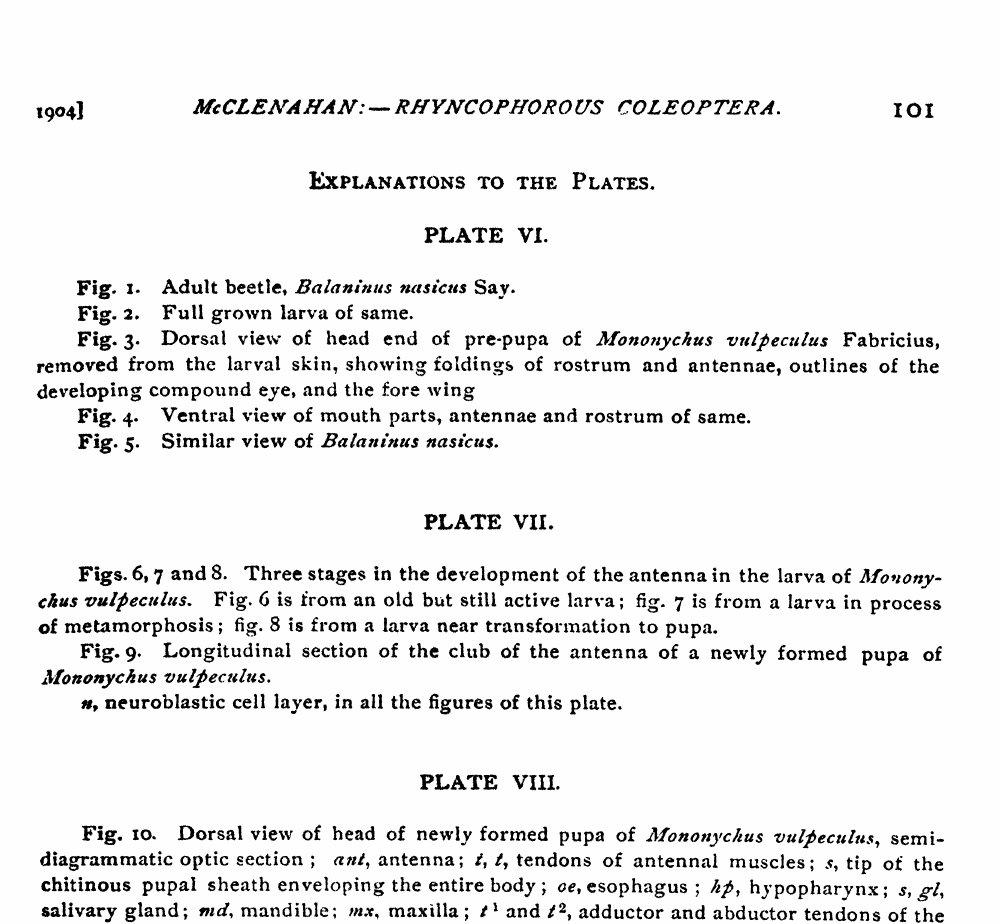
Fig. Io. Dorsal view of head of newly formed pupa of 3lononychus vulpeculus, semi- diagrammatic optic